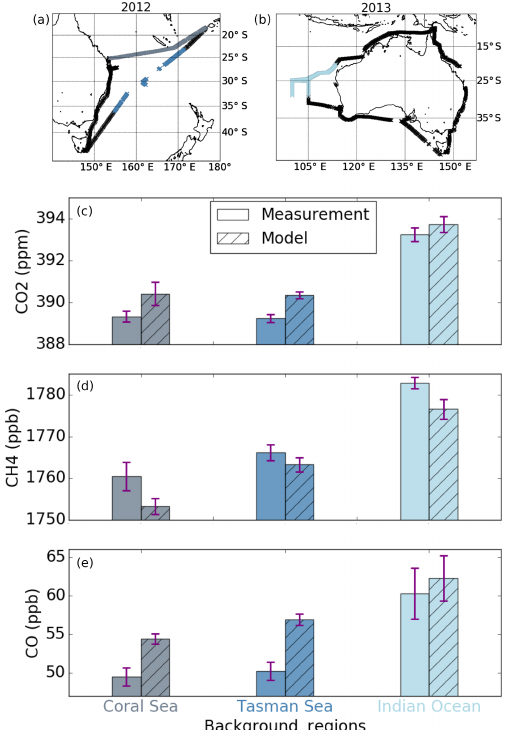
Figure 5. Measured and modelled CO 2 , CH 4 and CO concentra- tions from the ship cruises in different background regions with 1 standard deviation. The location of the sections where background values were observed are shown on the map. The measurements in the Coral Sea (grey) were collected during May 2012, in the Tasman Sea (dark blue) during June 2012 and in the Indian Ocean (light blue) during July